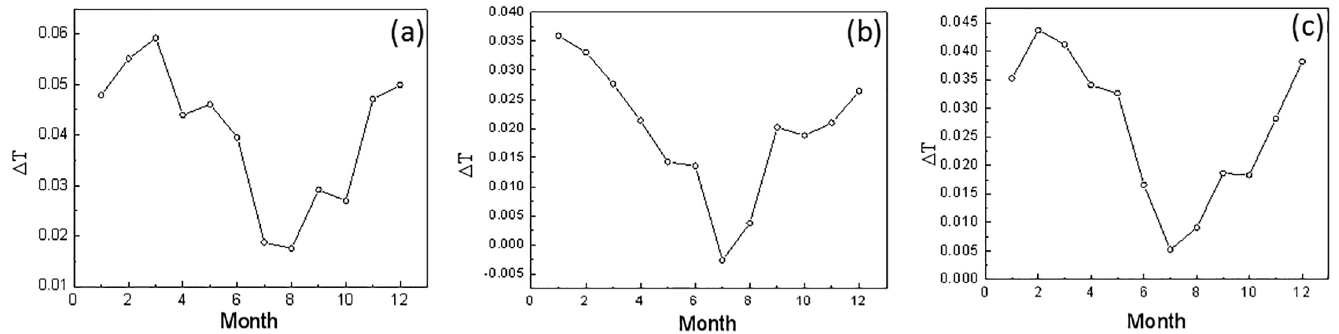
Fig 3. Warming rate of the monthly mean temperatures (units:˚C/100a) from 1909–2014 at (a) Harbin; (b) Changchun; (c) Shenyang.